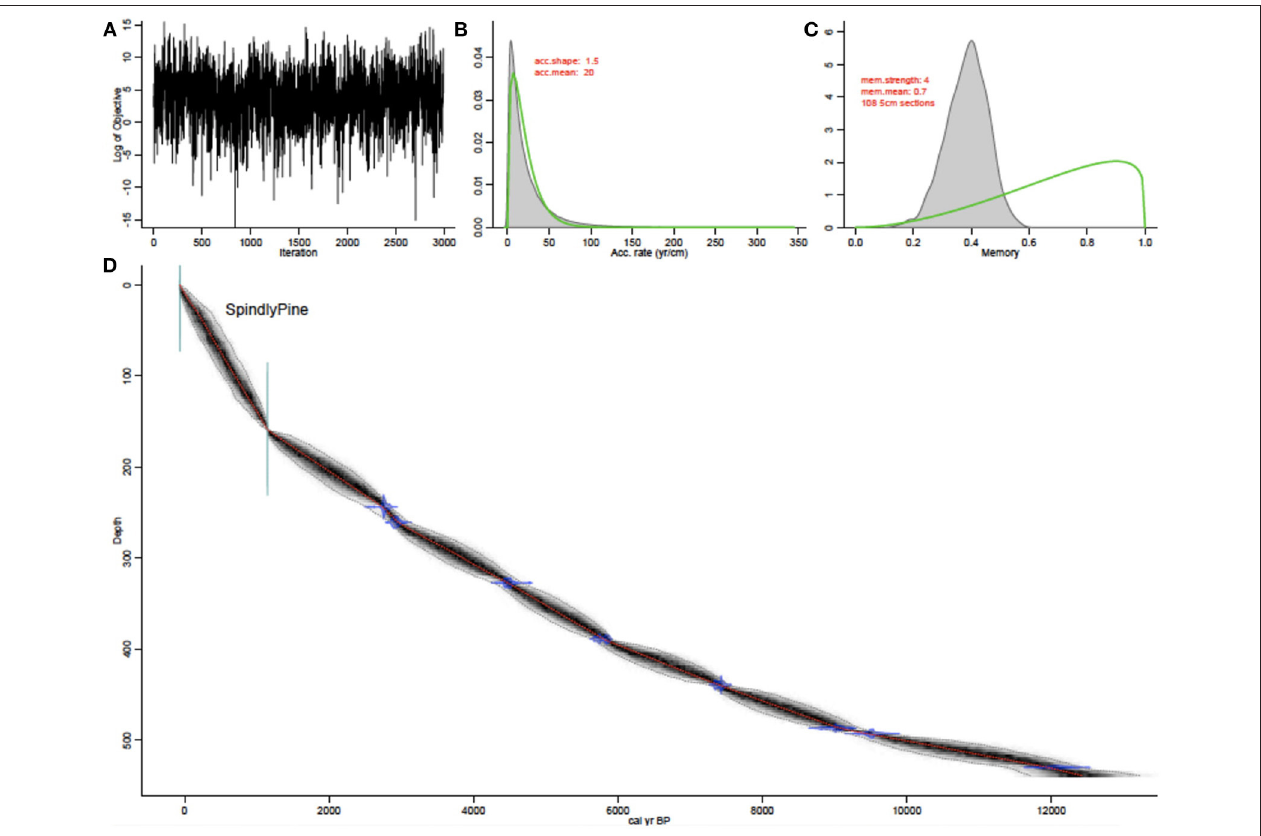
FIGURE 2 | (A) Markov chain Monte Carlo iterations of the BACON output; (B) Distribution of accumulation rates; (C) Memory/autocorrelation, demonstrating how the accumulation rate at depth in the core is dependent on nearby depths. Low memory indicates changing sedimentation rates throughout the core, while high memory indicates a more smooth, and consistent depositional history; (D) Age depth model created with BACON V 2.2 in R Studio. The horizontal green lines represent known dates, blue lines represent the 14 C dates and the red line is the model of best fit.